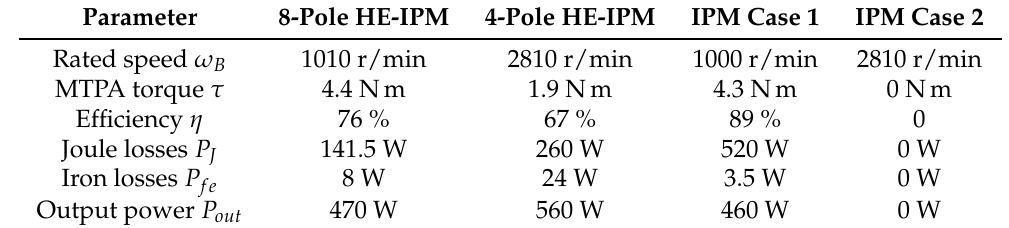
Table 5. Rated speed performance comparison between HE-IPM and IPM.